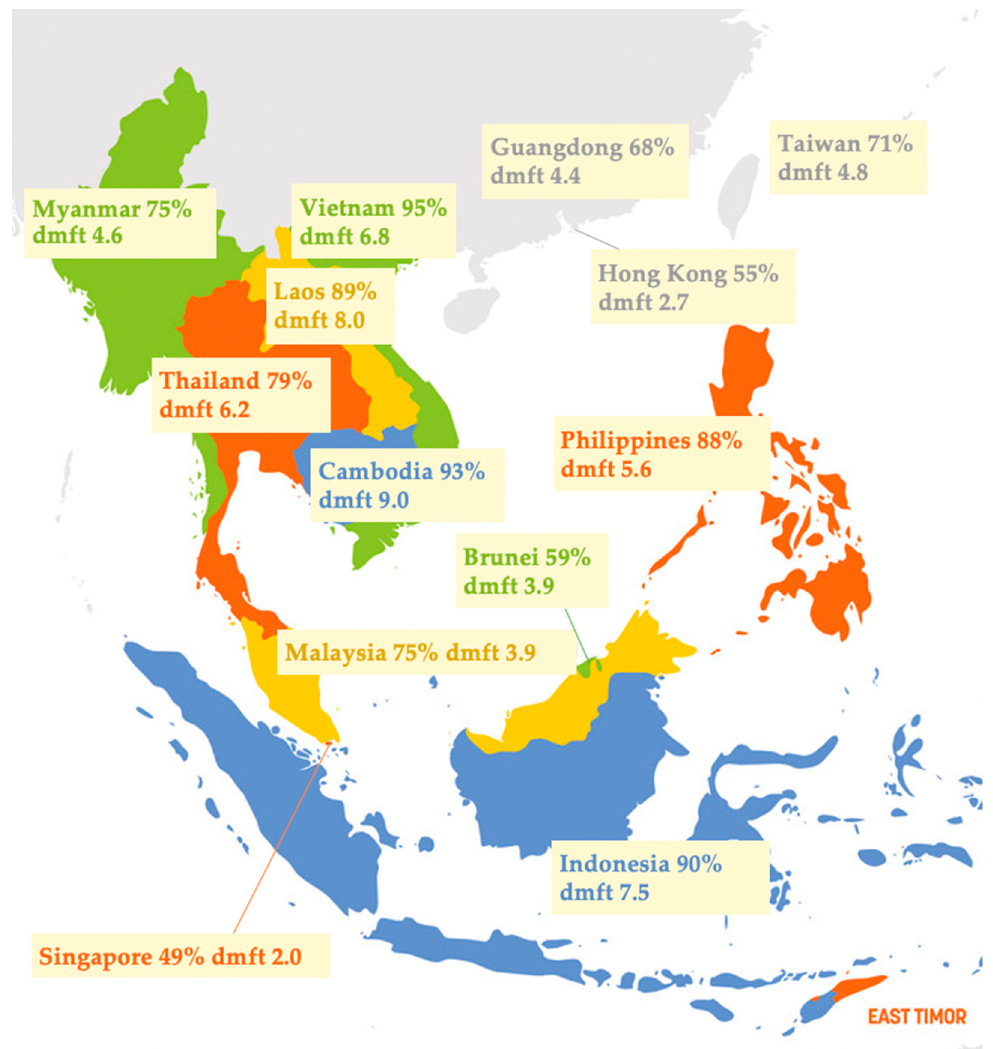
Figure 3. Caries prevalence (%) and caries experience decayed, missing and filled teeth (dmft) of 5-year-old children in Hong Kong and its nearby countries/regions. (adapted from Duangthip et al., 2017 ; Chen et al., 2019; Li et al., 2020 [8–10]).